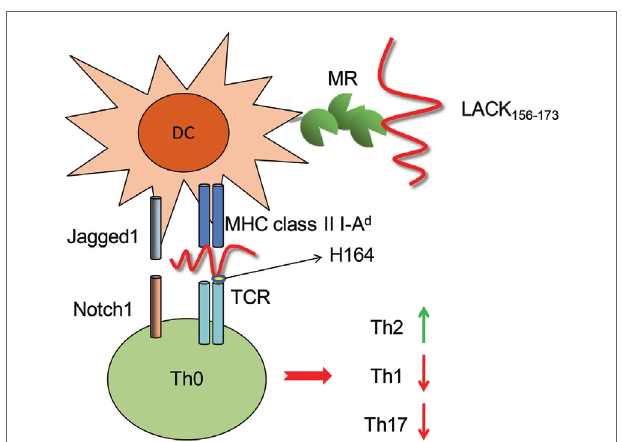
FigUre 8 | The effect of the LACK 156–173 epitope on T cell polarization. The LACK 156–173 epitope regulates the subsets, maturation, and functions of dendritic cells through binding to mannose receptor (MR), resulting in upregulation of Jagged1. The LACK 156–173 epitope is presented by major histocompatibility complex (MHC) class II I-A d molecules to V β 4 + /V α 8 + T cells and induces T helper (Th)2 cell polarization. Its effects are dependent on residue